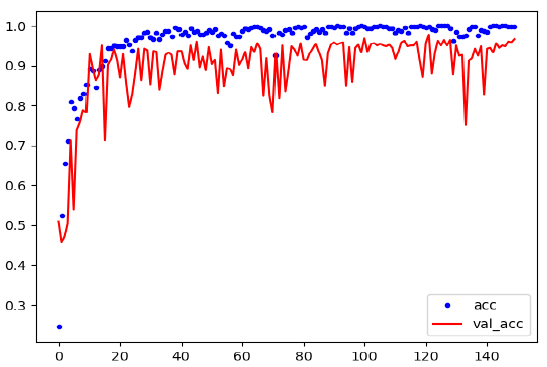
Figure 8. Examples of detection results using DSTEENet on GNEU dataset, green box indicating defect location with confidence score.